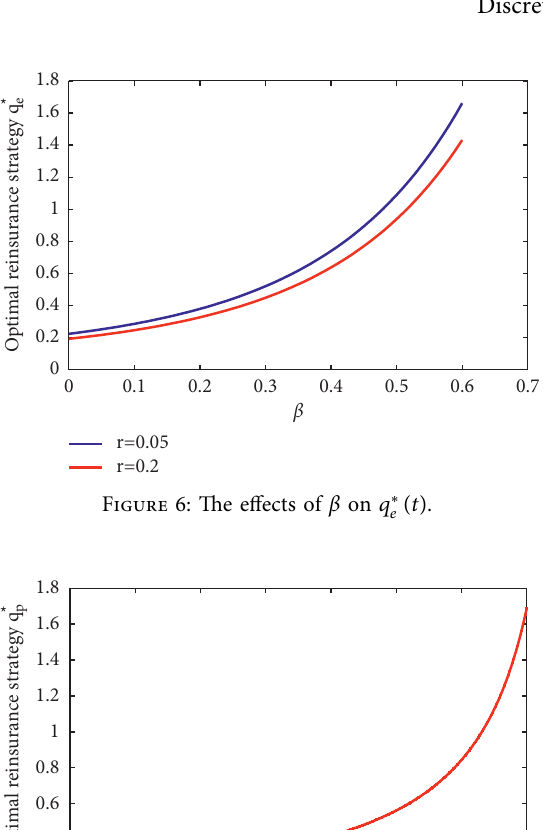
Figure 7: The effects of p on q ∗